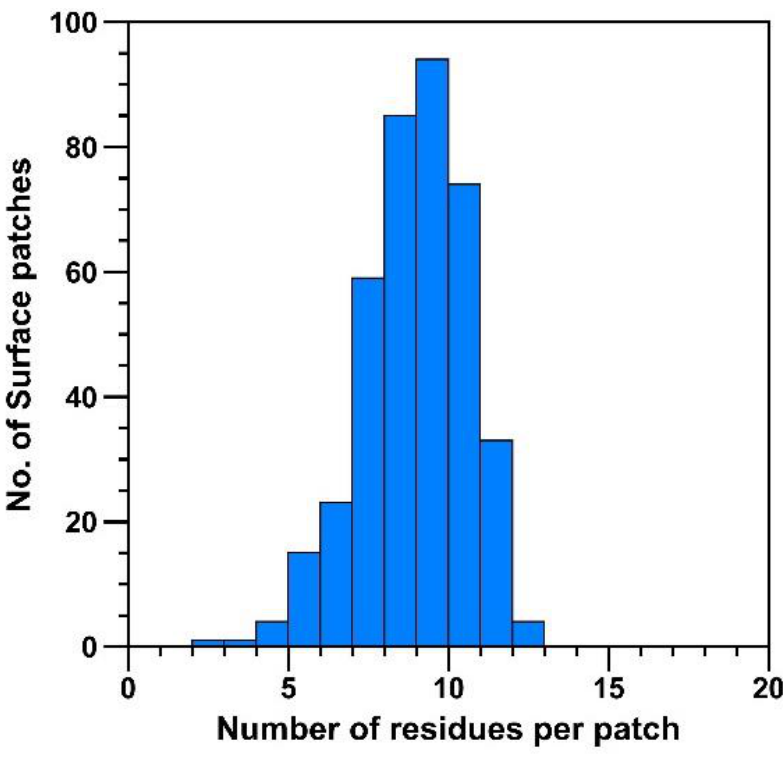
Figure A4. Number of residues per surface patch when the angle cutoff for adjacent residue inclusion within a surface patch was 125°.